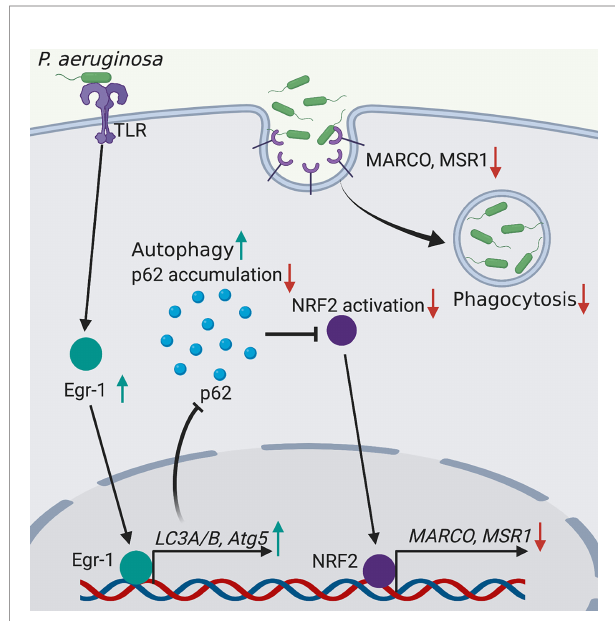
FIGURE 5 | Schematic illustration of Egr-1-regulated macrophage phagocytosis of P. aeruginosa . Egr-1 enhances the P. aeruginosa -induced autophagy by upregulation of the autophagy-related proteins LC3A, LC3B and Atg5 and decreases accumulation of p62, leading to reduced NRF2 activation associated with downregulated expression of scavenger receptors MACRO and MSR1, thus suppressing the phagocytosis of P. aeruginosa by